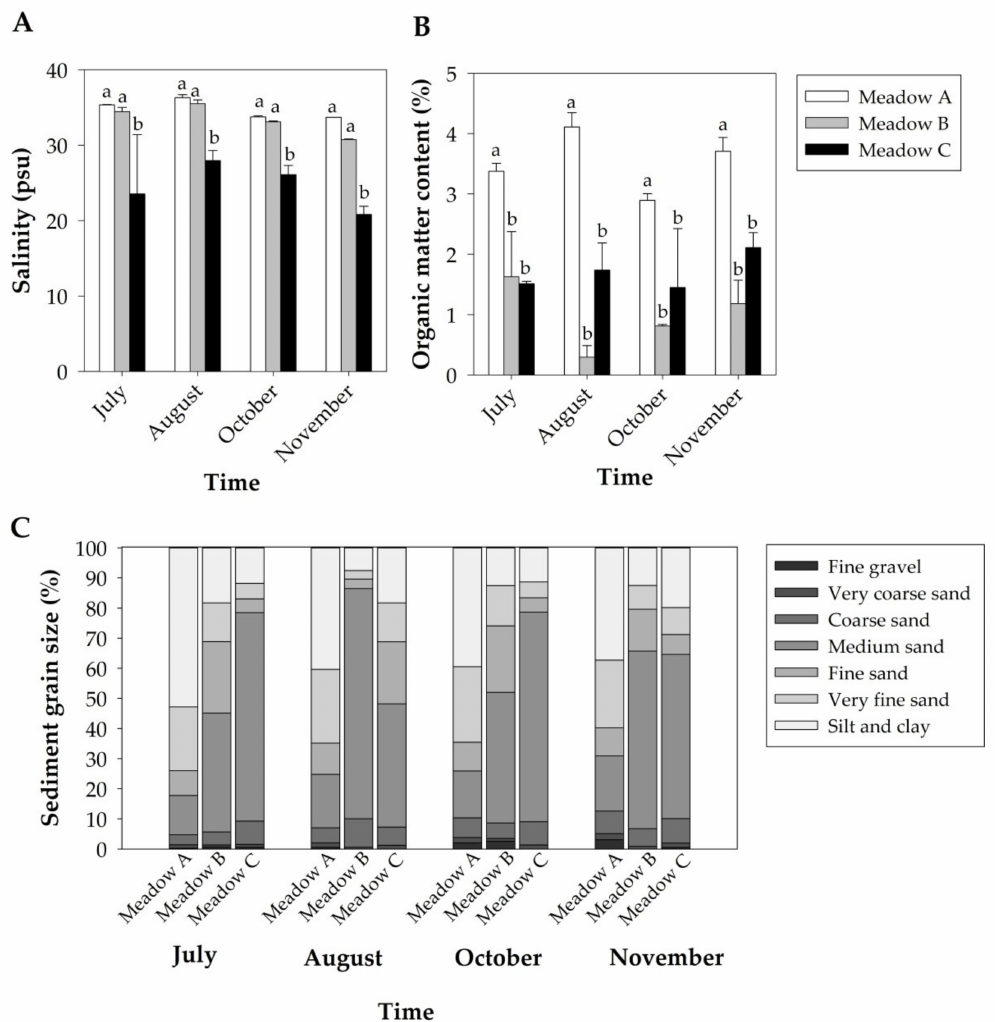
Figure 2. Abiotic parameters (Mean + SE, n = 2) of the studied Z. noltei meadows along the study period: seawater salinity ( A ), organic matter content of the sediment ( B ) and sediment grain size ( C ). Letters above error bars indicate significant differences among